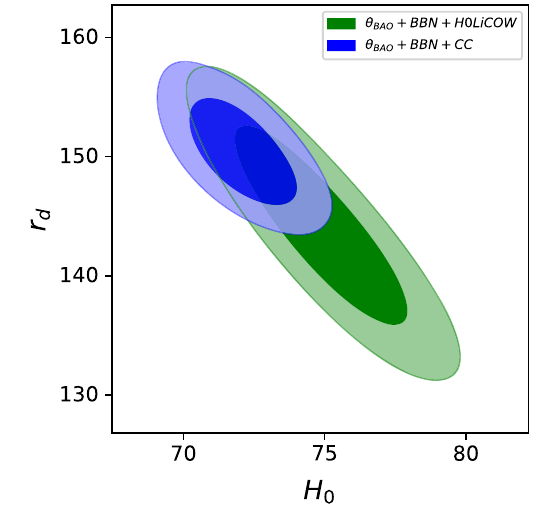
Fig. 1 Left panel: The 68% CL and 95% CL regions in the H 0 − (cid:3) m plane, inferred from θ BAO + BBN analyses in combination with H0LiCOW and CC data. The vertical light-purple and light-red bands correspond to H 0 from BAO + BBN taken from [54] and the SHOES